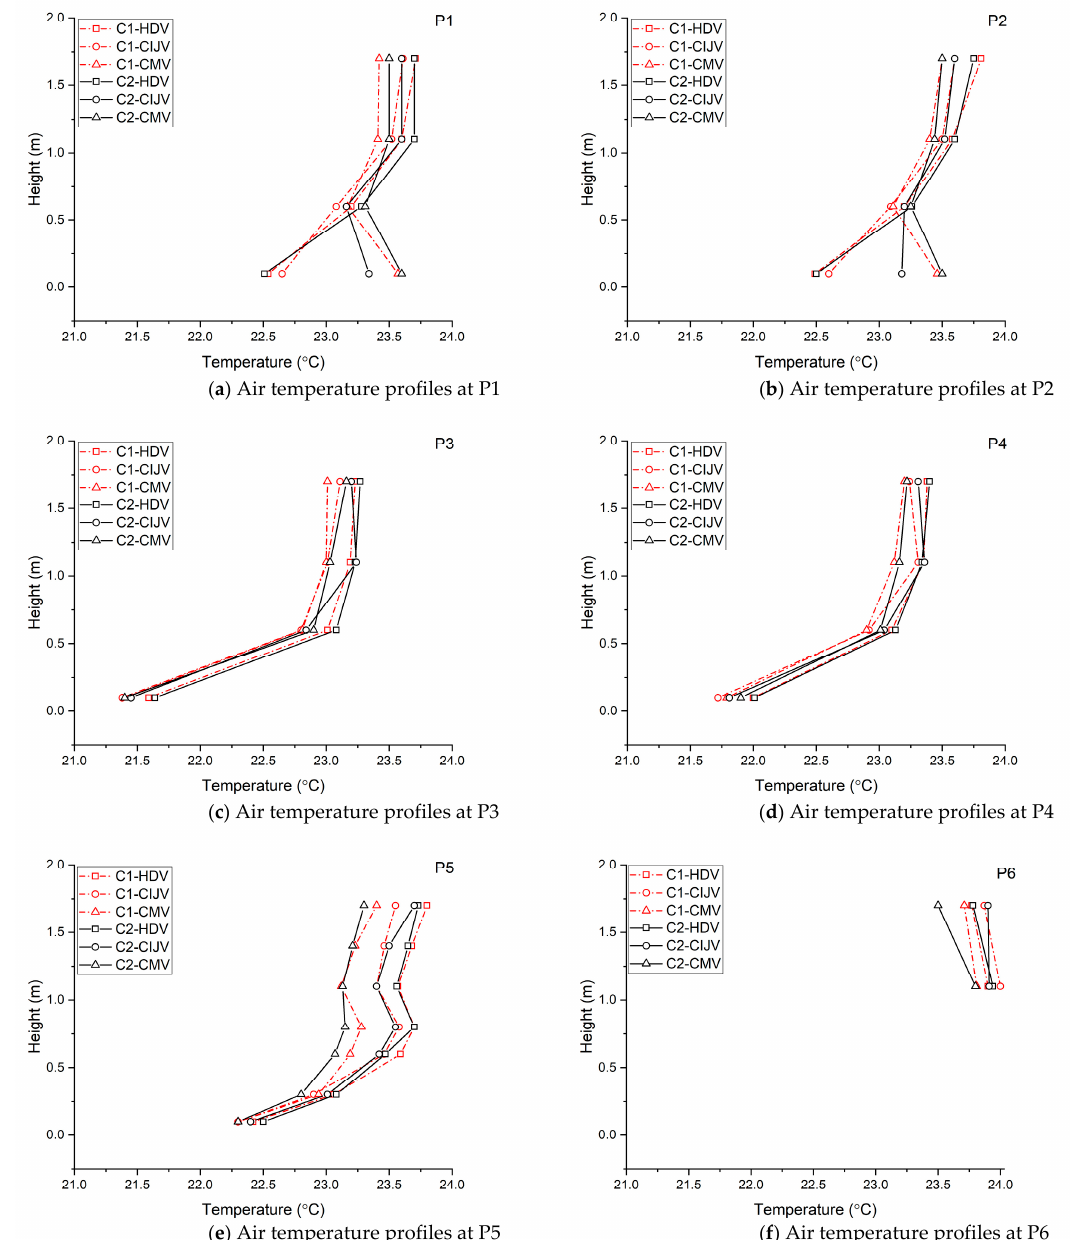
Figure 3. Air temperature profiles at position P1 ( a ), P2 ( b ), P3 ( c ), P4 ( d ), P5 ( e ) and P6 ( f ) for all cases.